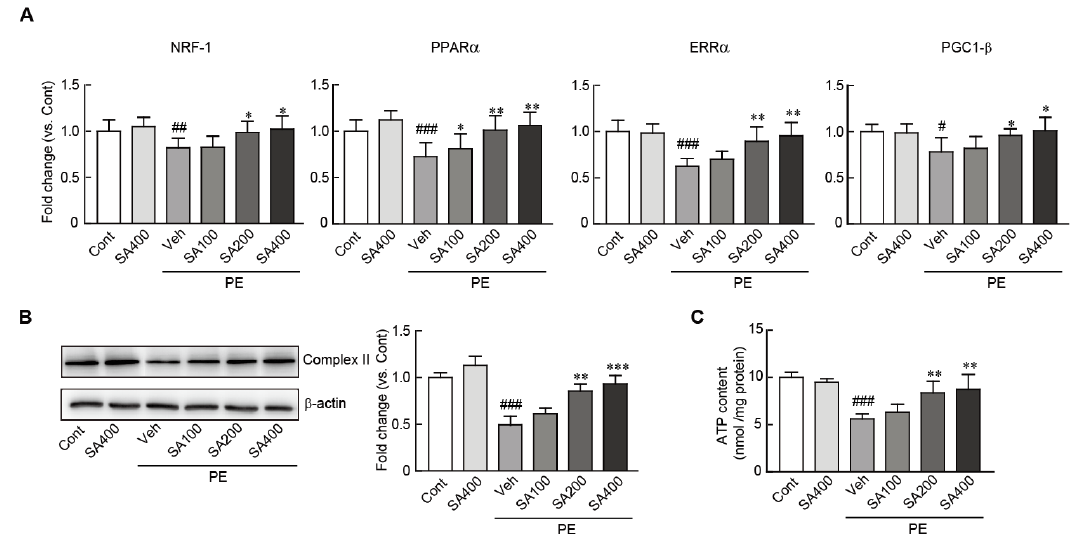
Figure 4. SA preserves mitochondrial integrity in PE-induced hypertrophic cardiomyocytes. ( A ) qRT-PCR analysis of mitochondrial biogenesis-related genes (NRF, PPAR α , ERR α , and PGC1- β ). ( B ) The expression level of complex II, a mitochondrial structure-related protein, was measured by Western blot analysis. The band densities were measured by using NIH ImageJ software. β -actin was used as a loading control. The analyses were performed in triplicate, using three independent samples. ( C ) ATP levels were luminometrically measured in SA-pretreated cardiomyocytes treated with PE. Data are expressed as the mean ± standard error of the mean (SEM). Significance was assessed by one-way analysis of variance (ANOVA) with a Bonferroni post hoc test. # P < 0.05, ## P < 0.01, and ### P < 0.001 vs. the control group; * P < 0.05 and ** P < 0.01, and *** P < 0.001 vs. the PE-only treated group. Veh, vehicle-treated; SA100, SA200, and SA400, 100, 200, and 400 µ M SA-treated groups, respectively; PE, phenylephrine; Cont, control; SA, sinapic